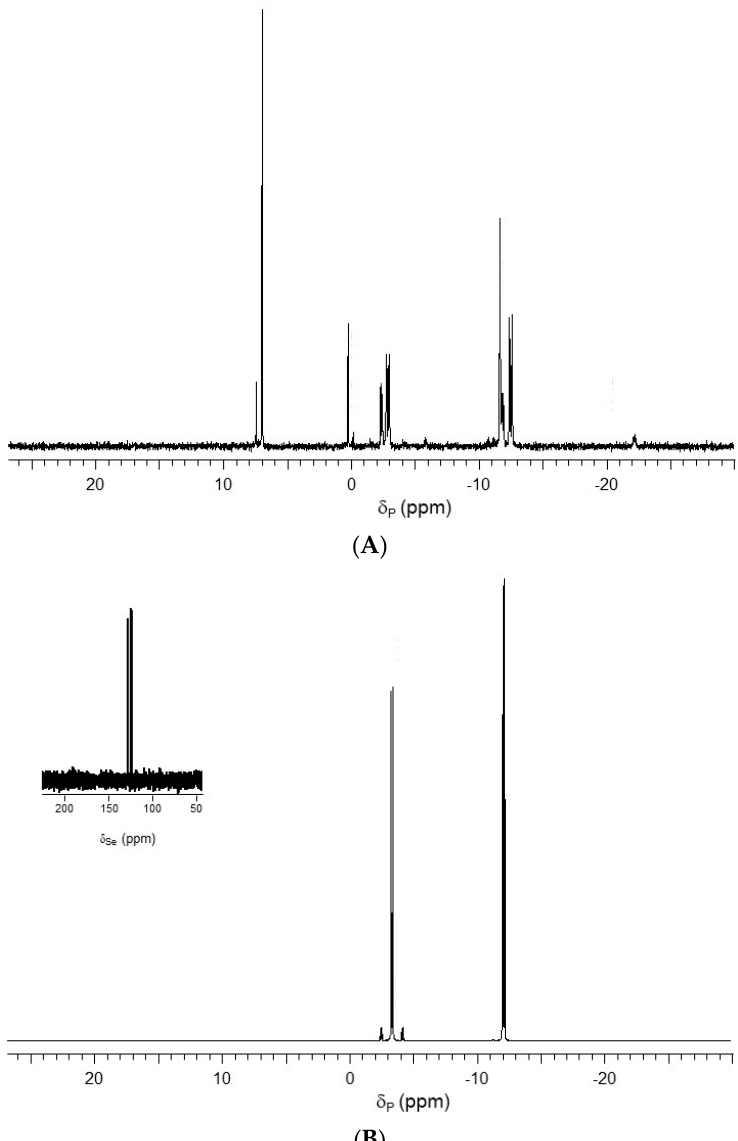
Figure 4. ( A ) 31 P{ 1 H} NMR of crude ball mill reaction mixture of dTSeppA ( 2b ); and ( B ) 31 P{ 1 H} and (inset) 77 Se NMR of 2b following purification and desalting.